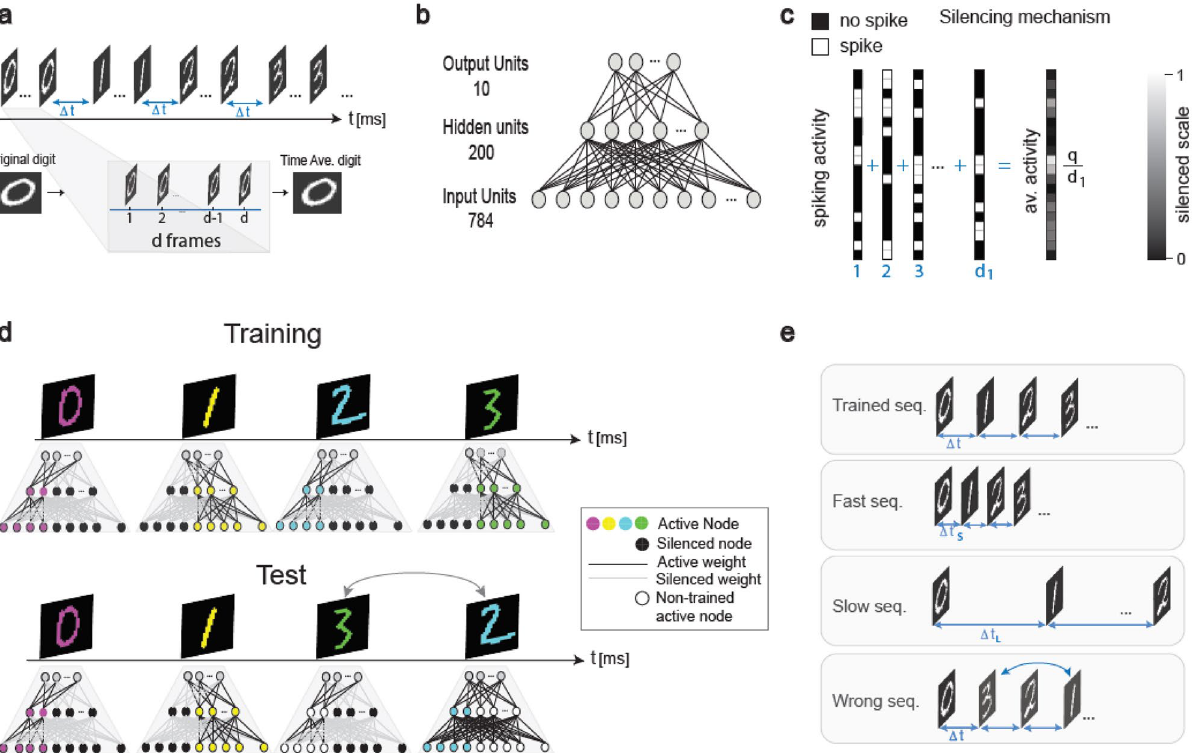
Figure 1. Brain-inspired ID-net. ( a ) Scheme of a sequence comprising 10 different MNIST digits separated by (cid:31) t , where each digit in the SFNN is represented by d Boolean frames. ( b ) Fully-connected SFNN architecture comprising 784/200/10 input/hidden/output units, respectively. ( c ) Scheme of the silencing mechanism of each hidden unit following its relative activity, q d , in the last d 1 frames of the previous digit. The same rule is 1 attributed to the input nodes. ( d ) Training: Scheme where each colored digit is trained on a different sub-SFNN; for simplicity, the nodes are either active (colored following the digit) or silenced (black), and the weights are silenced accordingly. Test: A wrong test sequence where the positions of digits 2 and 3 have been exchanged. The active nodes for digit 3 (white) differ from its trained nodes (green, Training) and corresponding trained wrong—in test sequences relative to the trained